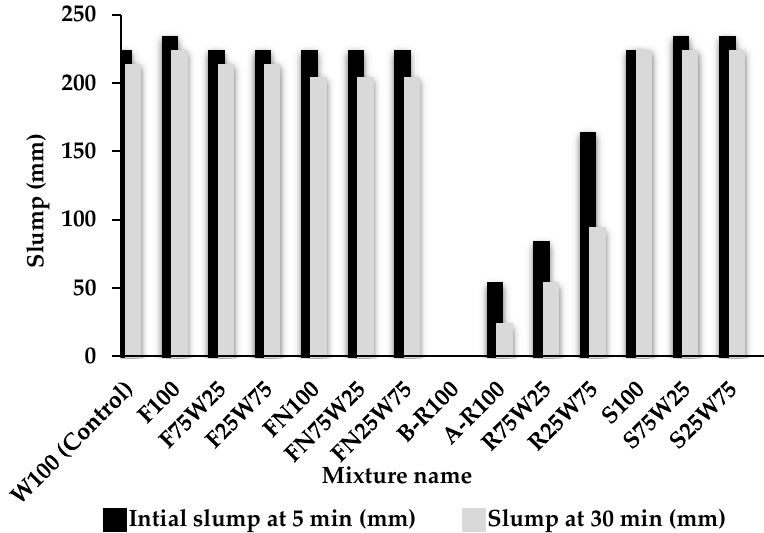
Figure 2. Average concrete mix slump using di ff erent mixing water at 5 min and 30 min after mixing. Well water was used as mixing water in control specimen. Mixtures (A-R100, B-R100, R75W25, and R25W75) contain more than 25% raw WWW. Each data point was measured in triplicate.